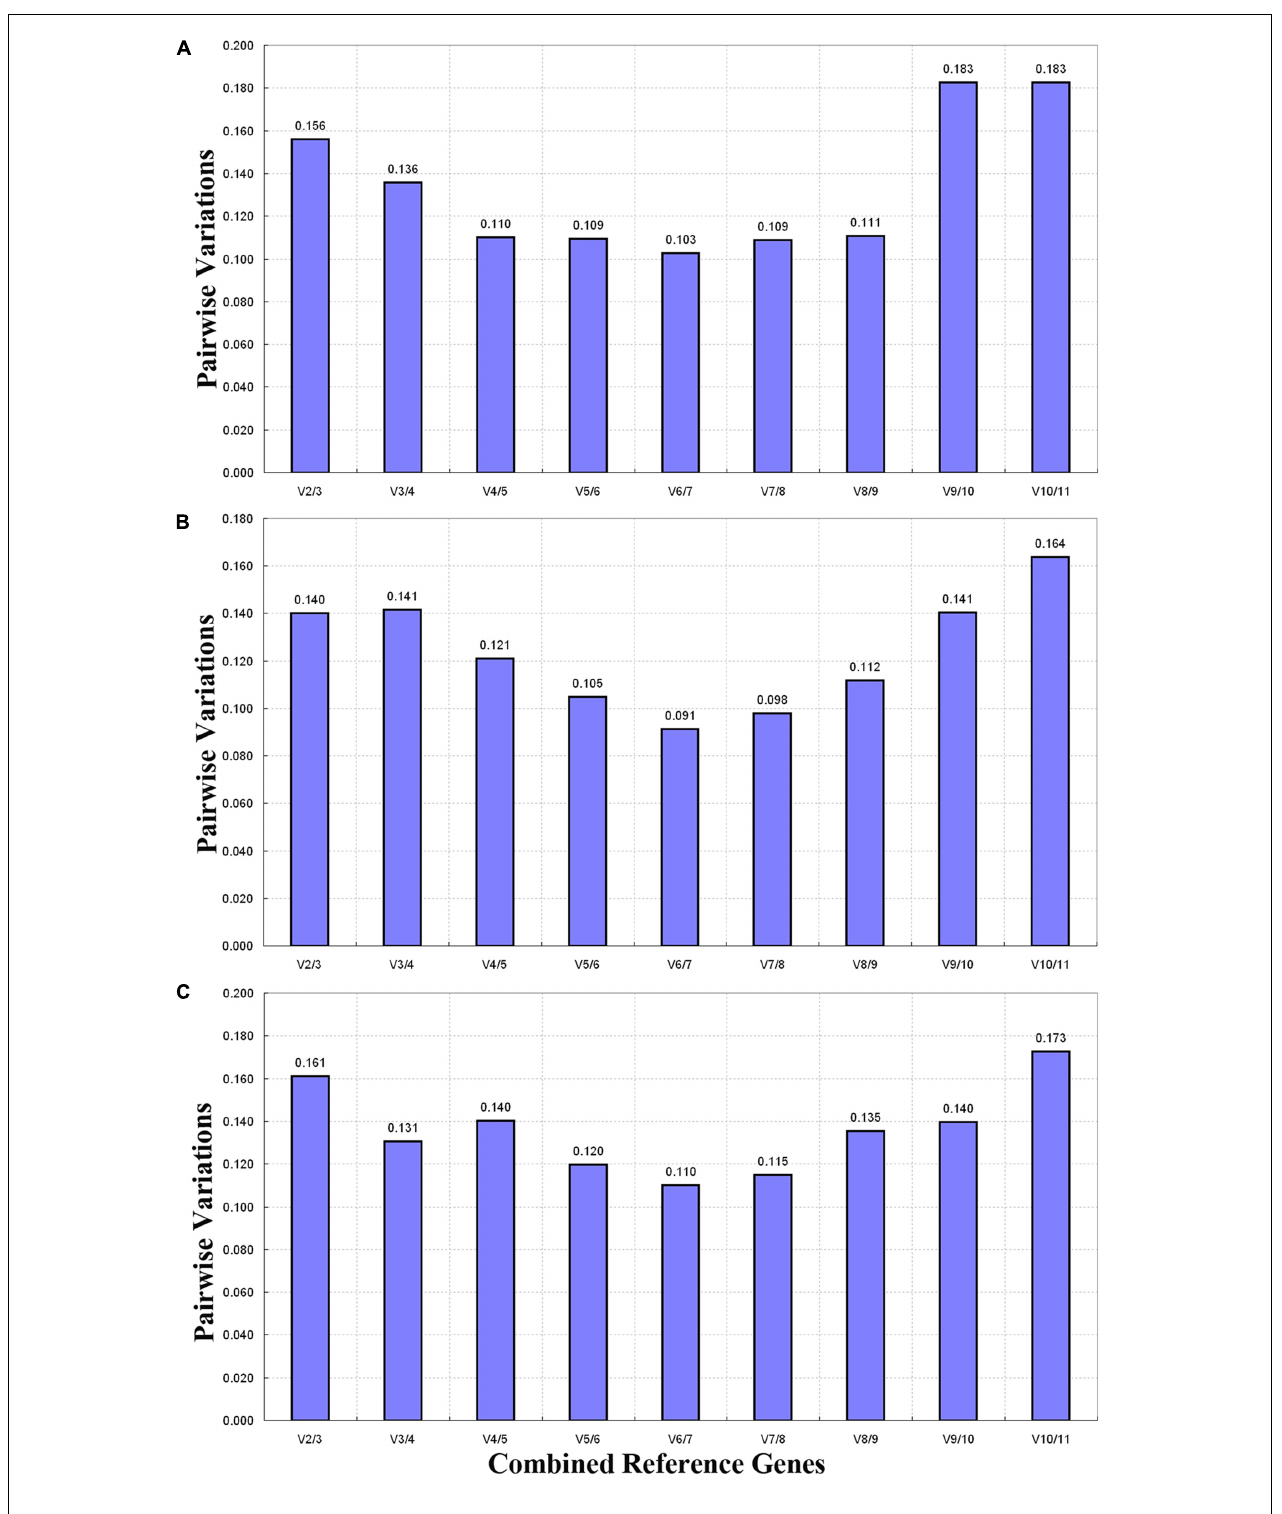
FIGURE 4 | Pairwise variation (V) calculated through GeNorm to determine the optimal number of reference genes. The average pairwise variation ( V n / V n + 1 ) between normalization factors NF n and NF n + 1 was analyzed to determine the optimal number of reference genes required for qRT-PCR data normalization in different samples. (A) Different tissues, (B) flower samples of different developmental stages, and (C) all samples.